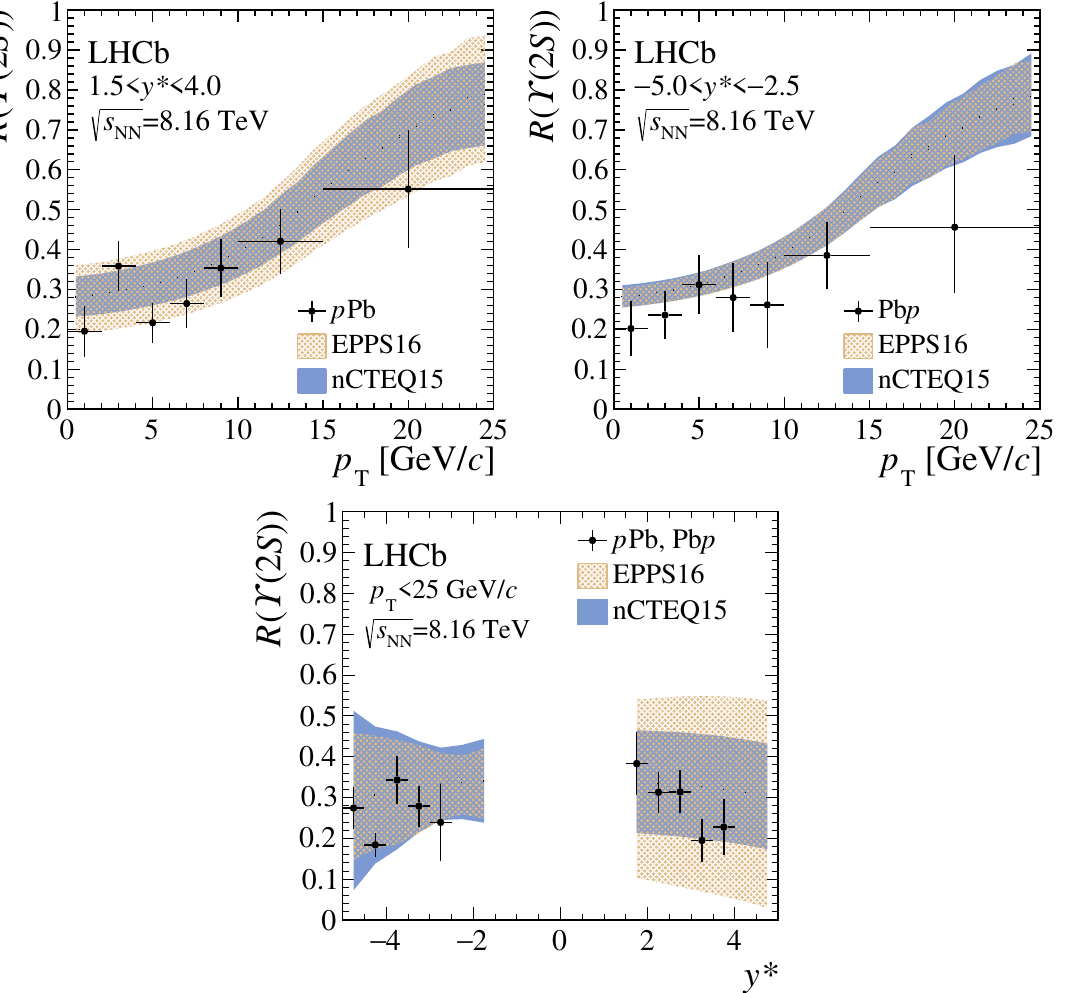
Figure 10 . Ratios between (cid:7) (2 S ) and (cid:7) (1 S ) cross-sections as a function of (top) p T integrated over y (cid:3) , and as function of (bottom) y (cid:3) integrated over p T , for p Pb and Pb p collisions. The bands correspond to the theoretical predictions for the nCTEQ15 and EPPS16 nPDFs sets as reported in the text.